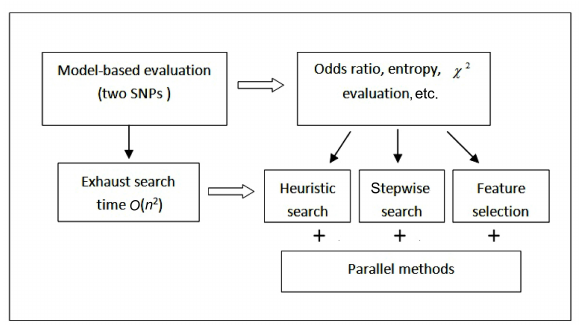
Fig. 2 From two-locus SNP detection to k -locus SNP detection.